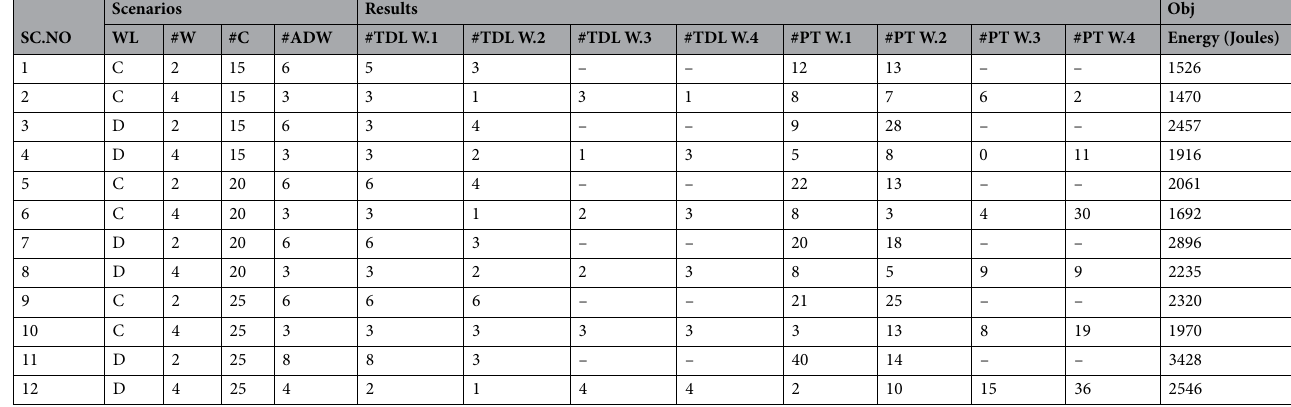
Table 2. Computational result experimental test design under different scenarios. SC.NO: Scenario number, WL: Warehouse Location type, in which C stands for Centralized and D stands for Decentralized, #ADW: Number of Available Drones at each Warehouse, #TDLW.1: Number of Drones Launched from Warehouse 1, #PTW.1: Number of Public Transportation used for Warehouse 1 delivery operations, Obj: Total consumed energy, C-2–15: Abbreviated names of